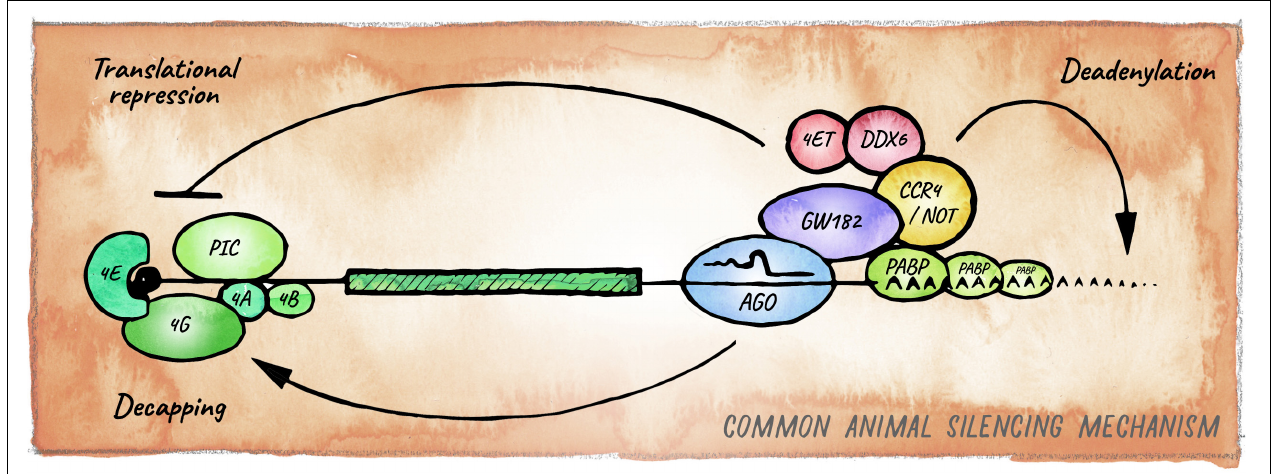
FIGURE 3 | Canonical miRNA-silencing mechanism in animals. miRNAs elicit repression of target genes usually through a combination of translational repression and promotion of mRNA decay. Argonaute is guided by a miRNA to a cognate target mRNA and tethers GW182, forming the core of the most common animal miRISC. GW182 interacts with PABP and recruits the deadenylase complexes CCR4-NOT or Pan2-Pan3 (not shown), leading to deadenylation, decapping and ultimately exonucleolytic decay. Inhibition of translation occurs mainly at the initiation step by interfering with assembly or activity of eIF4F, via eIF4E-T, and